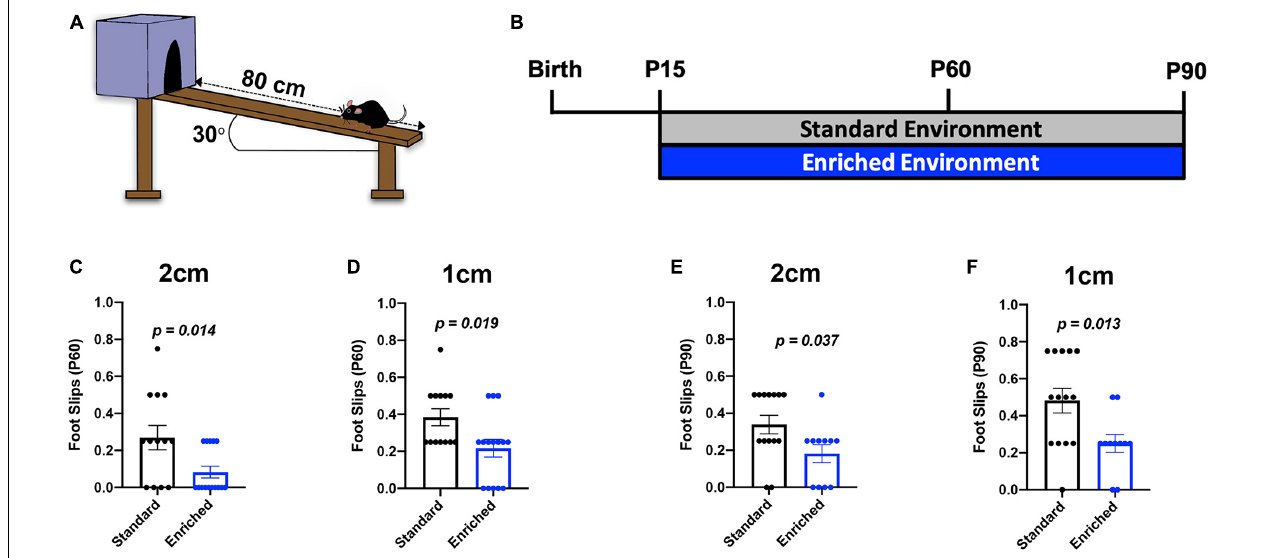
FIGURE 4 | Prolonged EE improves locomotor coordination. (A) Schematic depiction of the inclined beam-walking task. (B) Experimental timeline. (C) Quantification of foot slips for the 2-cm beam at P60. (D) Quantification of foot slips for the 1-cm beam at P60. (E) Quantification of foot slips for the 2-cm beam at P90. (F) Quantification of foot slips for the 1-cm beam at